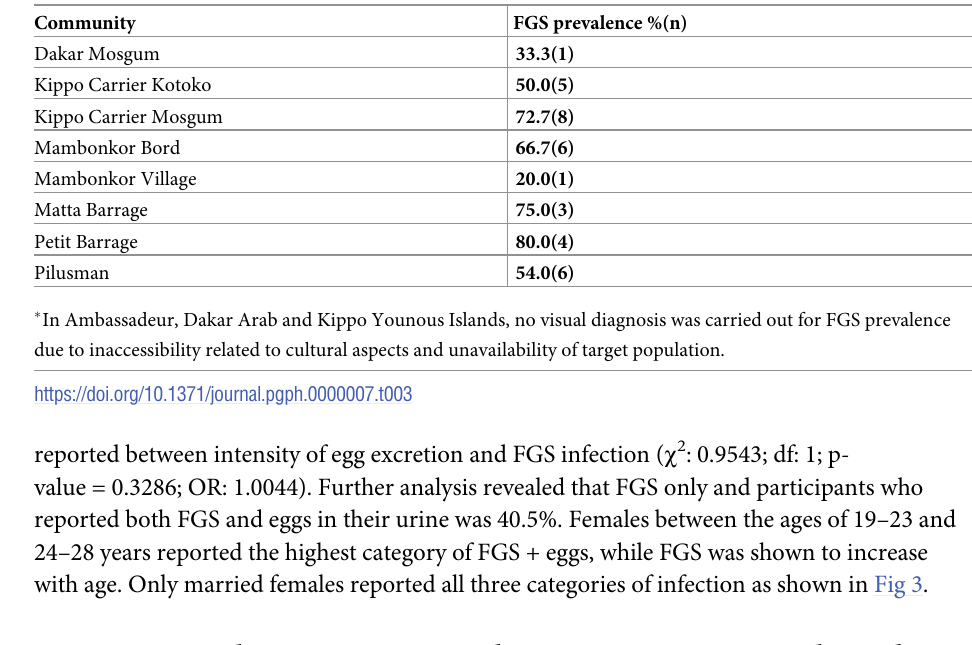
Table 3. FGS prevalence distribution per community.